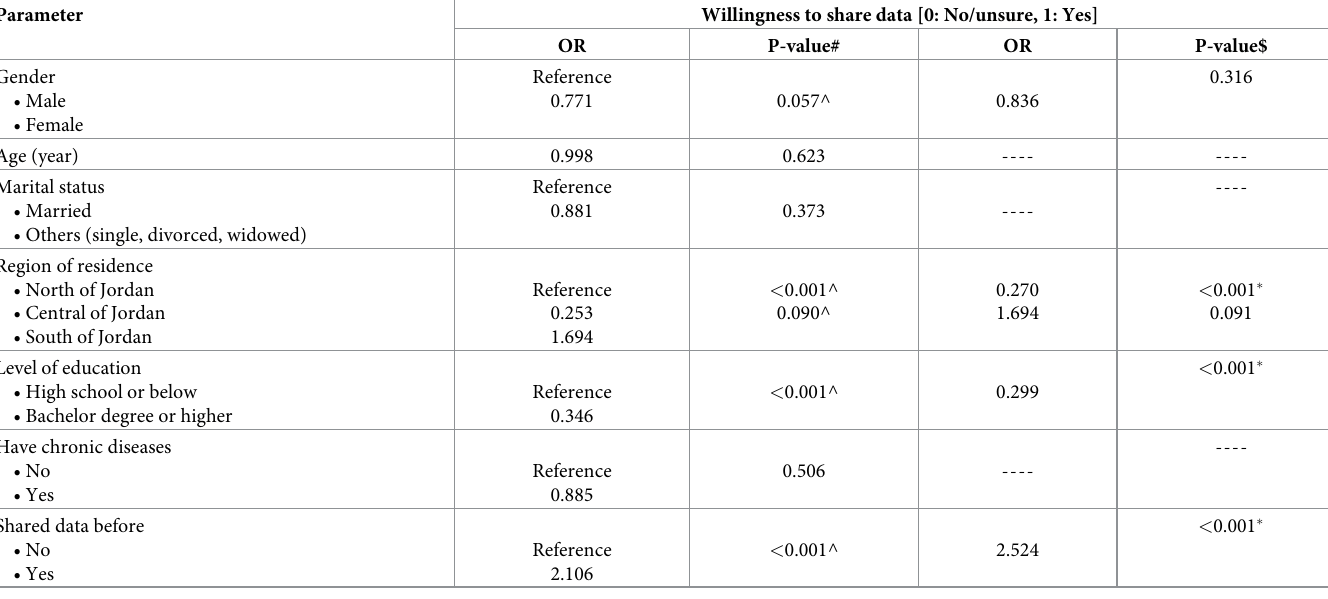
Table 4. Assessment of predictors affecting public willingness to share their medical data (n =